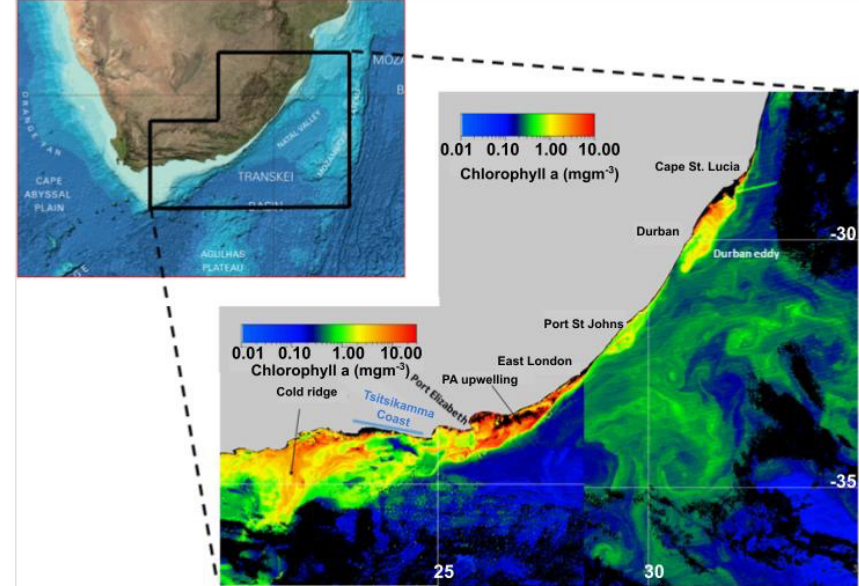
Figure 4. A composite chlorophyll satellite image chosen to highlight the main productivity features commonly found on the inshore edge of the Agulhas Current. Note the different chlorophyll scales applicable to the left-hand side (LHS) and right-hand side (RHS) parts of the composite. Highlighted are the cold ridge on the central Agulhas Bank (AB), Port Alfred upwelling extending onto the eastern AB, and the Durban (break-away) eddy with a similar feature passing Port St Johns where a semi-permanent smaller cyclonic feature often exists. The inset map is taken from GEBCO (General Bathymetric Chart of the Oceans,